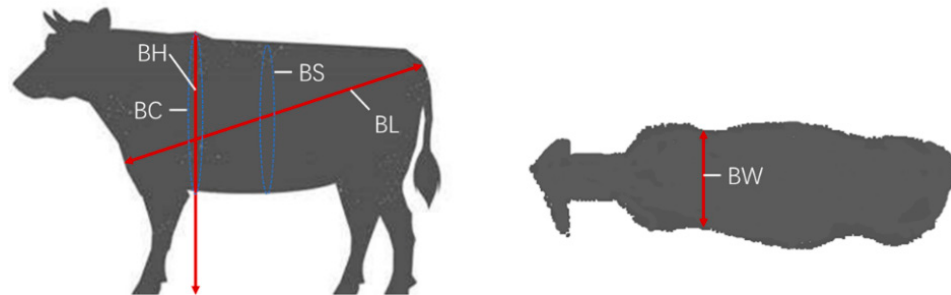
Figure 2. The measurement standard for key body dimensions of beef cattle.